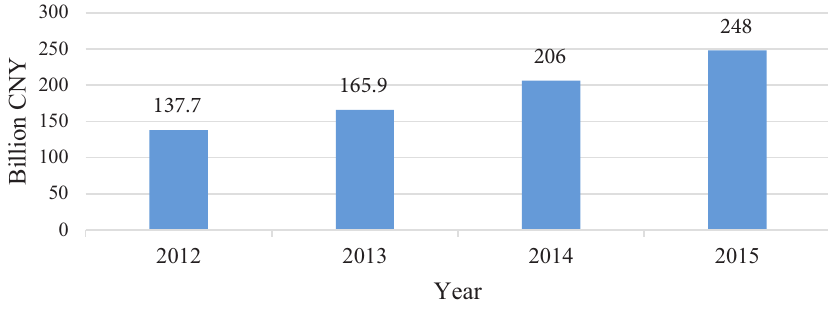
Figure 1. Investment on development smart cities in